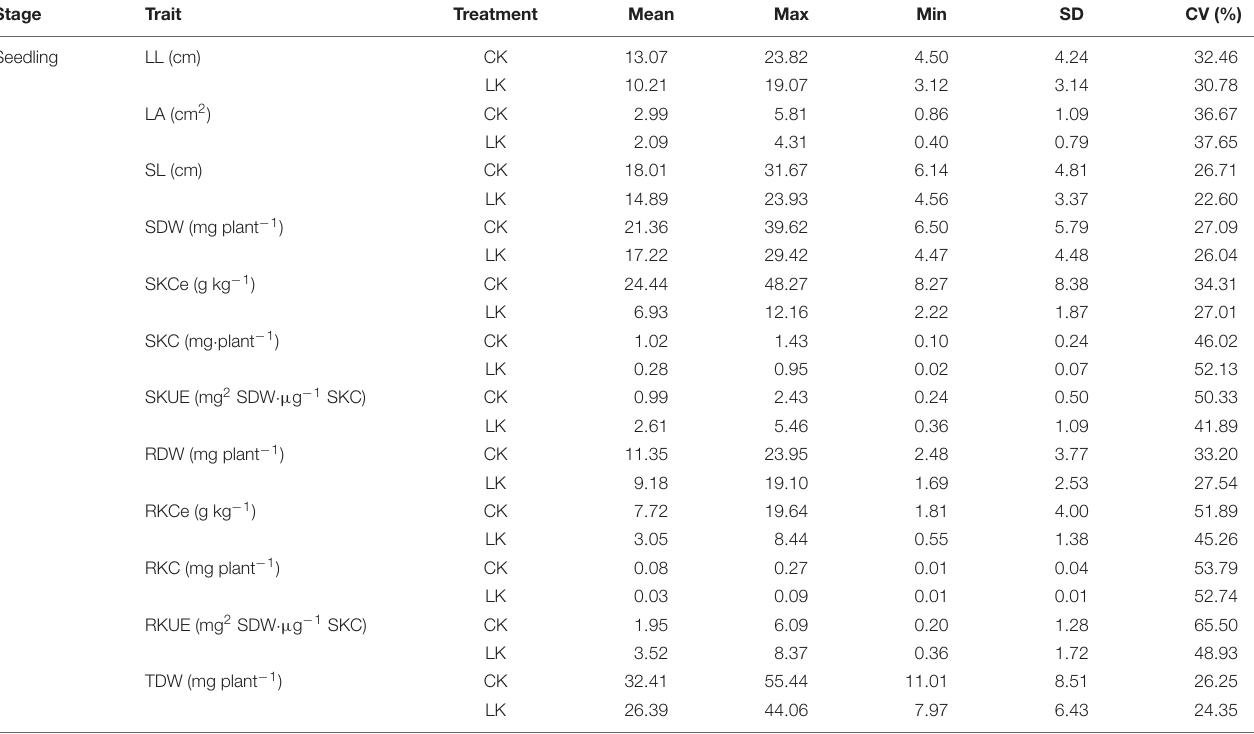
TABLE 1 | Phenotypic variations in the K utilization efficiency-related traits at the seedling stage. Stage Trait Treatment Mean Max Min SD CV (%) Seedling LL (cm)